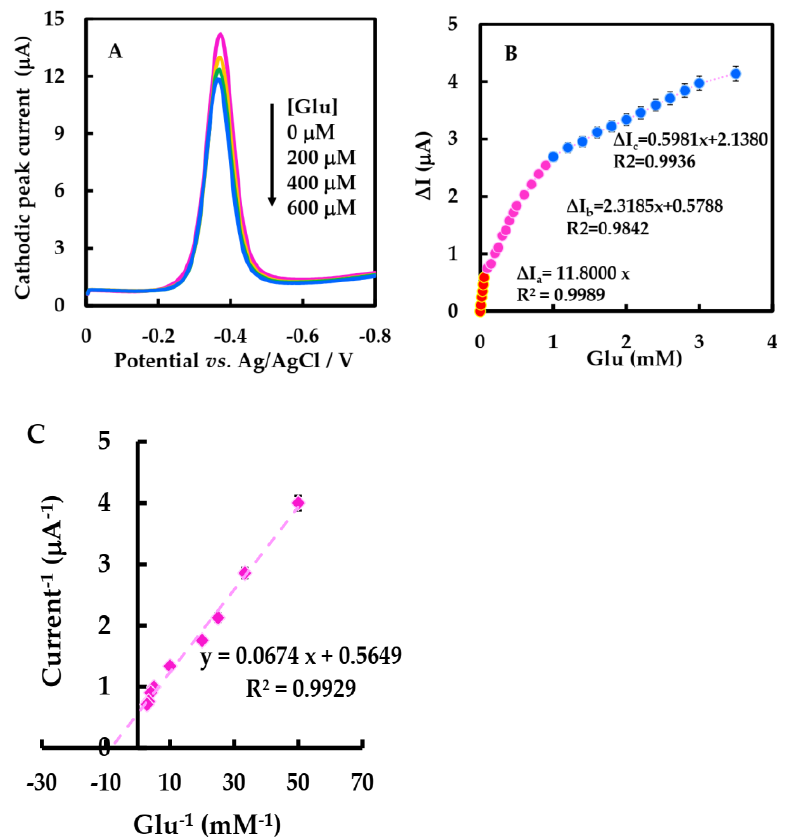
Figure 8. ( A ) DPVs of the NF-GLA/MWCNTs-BSA-HFs-GOD/GCE in air-saturated 50 mM, pH 6 phosphate-buffered solution at a scan rate of 0.05 V · s − 1 in the absence and presence of different concentrations of Glu (0, 0.2, 0.4, 0.6 mM). ( B ) Linear range from 0.01 mM to 3.5 mM. ( C ) Lineweaver- Burk plot for K mapp determination. Table 3. Electrochemical parameters of the electrodes recently modified for Glu detection.